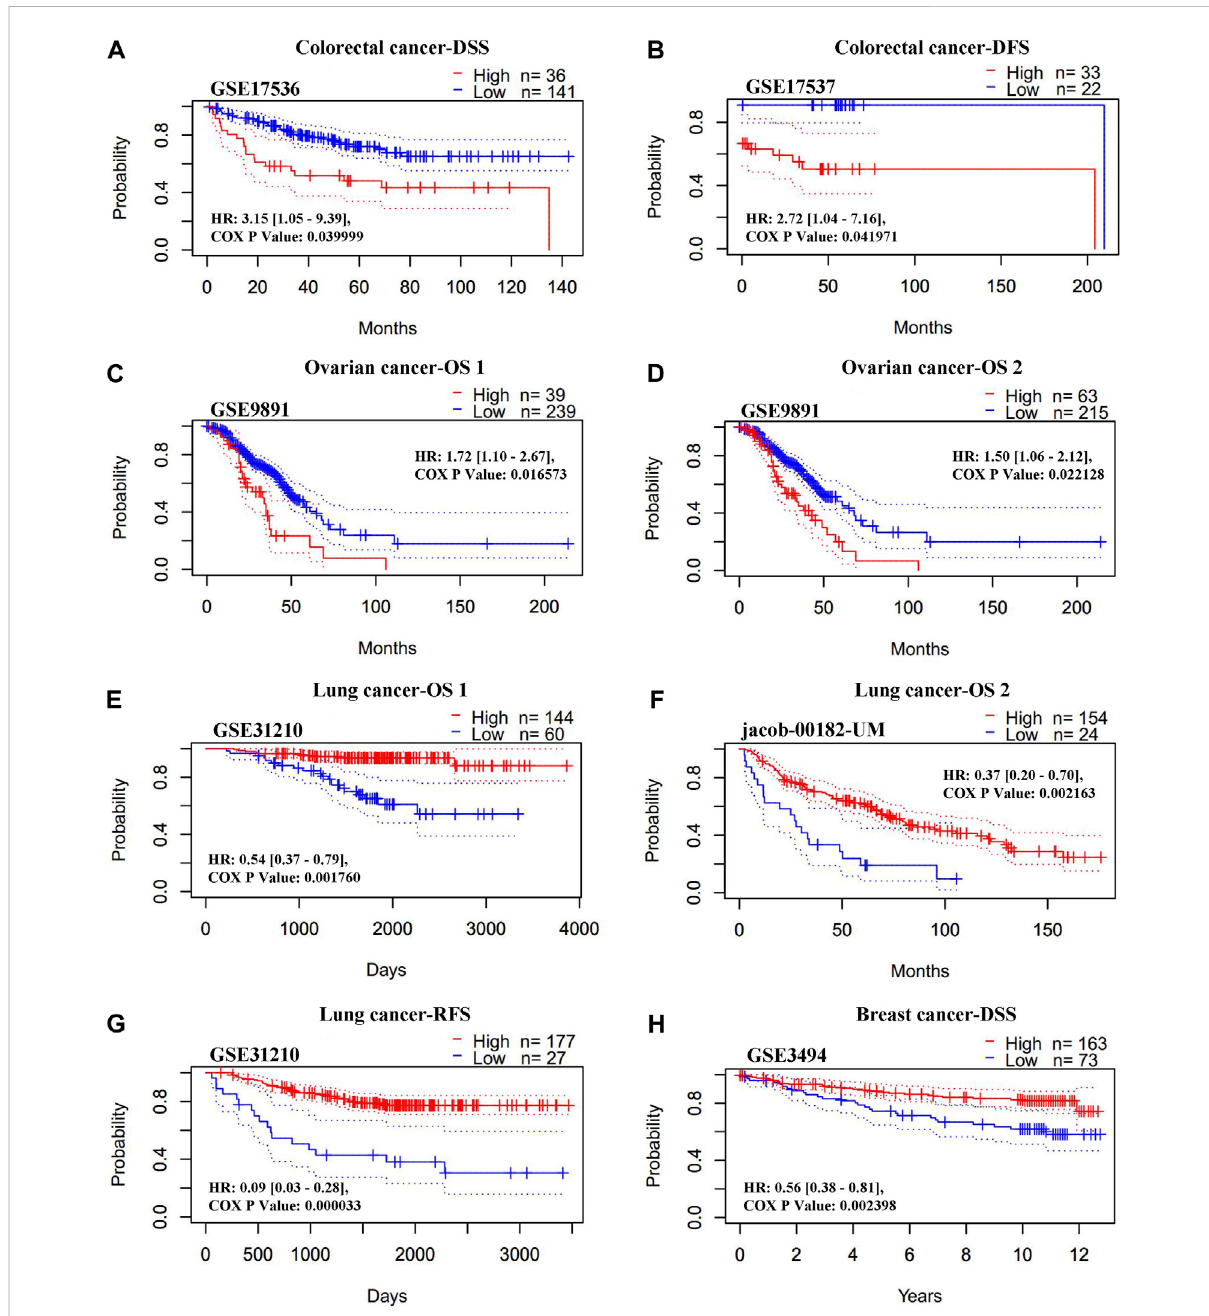
FIGURE 8 Correlation between REV1 expression and prognosis of various types of cancer [colorectal cancer (A, B), ovarian cancer (C, D) , lung cancer (E – G) , and breast cancer (H) ] (PrognoScan